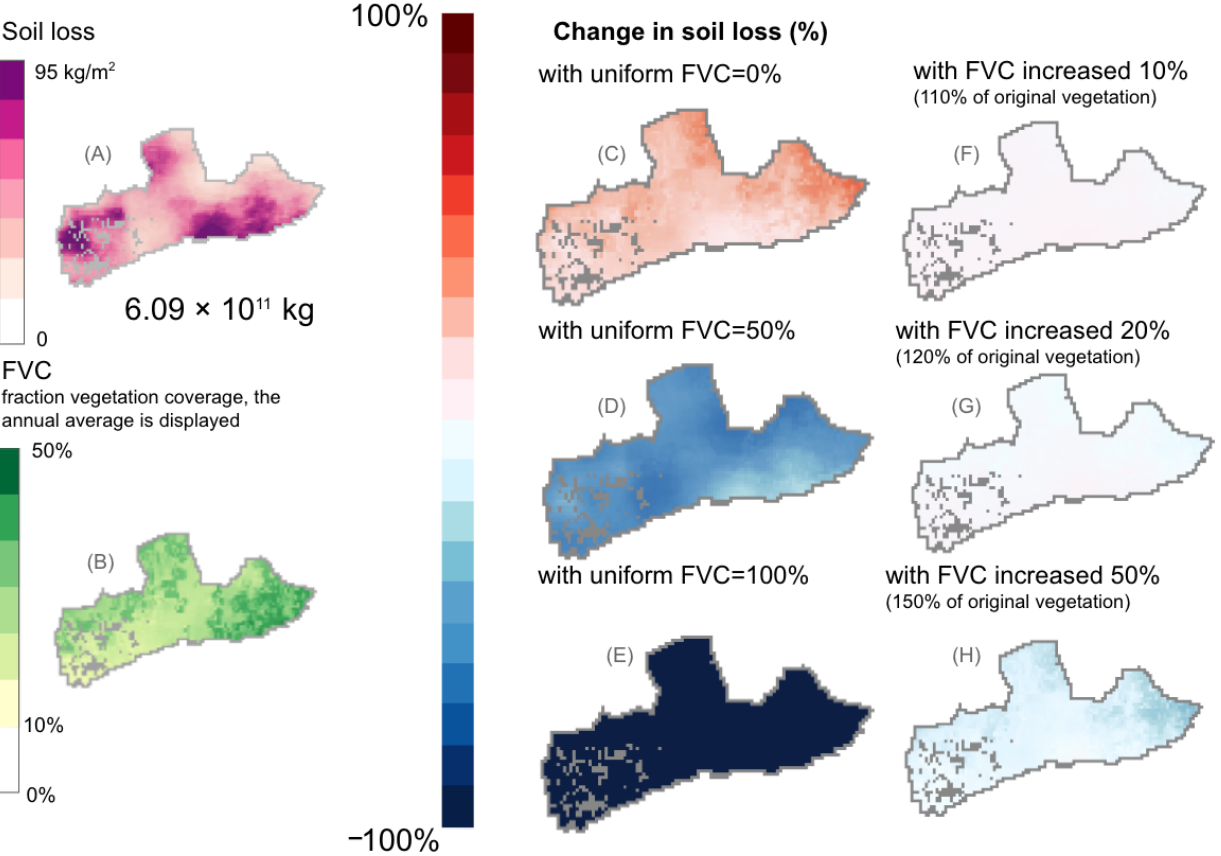
Figure 6. Soil loss with current vegetation, and six scenarios of vegetation cover. Figure ( A ) represents annual soil loss. Figure ( B ) represents the annual average fractional vegetation coverage. Figures ( C ) through ( H ) represent percent change in annual wind erosion with different hypothetical fractional vegetation